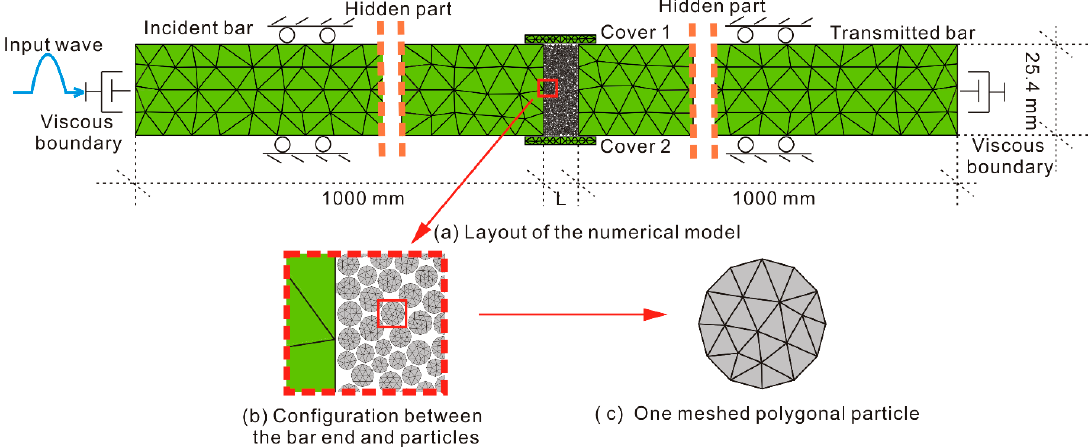
Figure 2. Layout of the FDEM model.